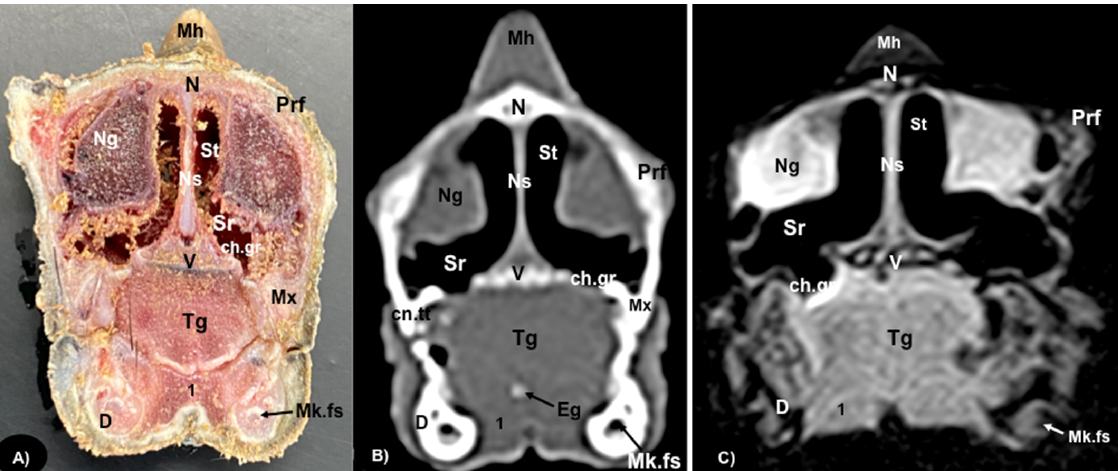
Figure 2. Transversal gross ‐ section ( A ), CT bone window ( B ), and MRI in T1W ( C ), images of the head of rhinoceros iguana at the level of the nasal cavity corresponding to line I in Figure 1. Mh: Medial horn. N: Nasal bone. Prf: Prefrontal bone. Ns: Nasal septum. Ng: Nasal glands. Sr: Subcon ‐